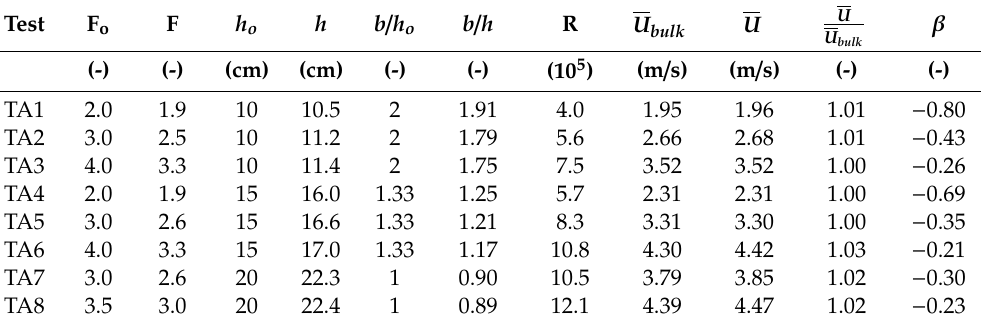
Table 1. Experiments with corresponding hydraulic parameters at the first measurement cross-section ( x = 5.40